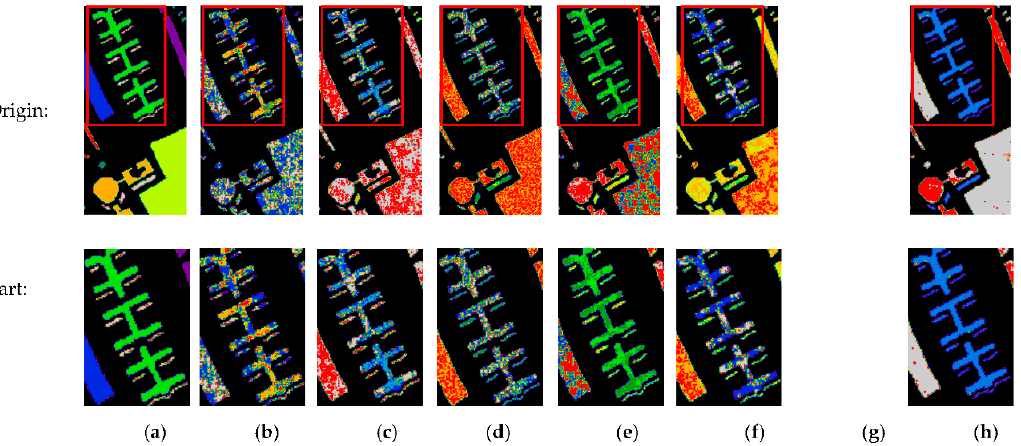
Figure 16. Clustering results obtained using different methods on the Pavia University data set with Gaussian noise and salt and pepper noise. ( a ) Ground truth. ( b ) LRSC 37.22%. ( c ) SSC 38.79%. ( d ) S4C 43.30%. ( e ) EDSC 47.91%. ( f ) EGCSC 50.92%. ( g ) EKGCSC. ( h ) SSAKGCSC 69.67%.